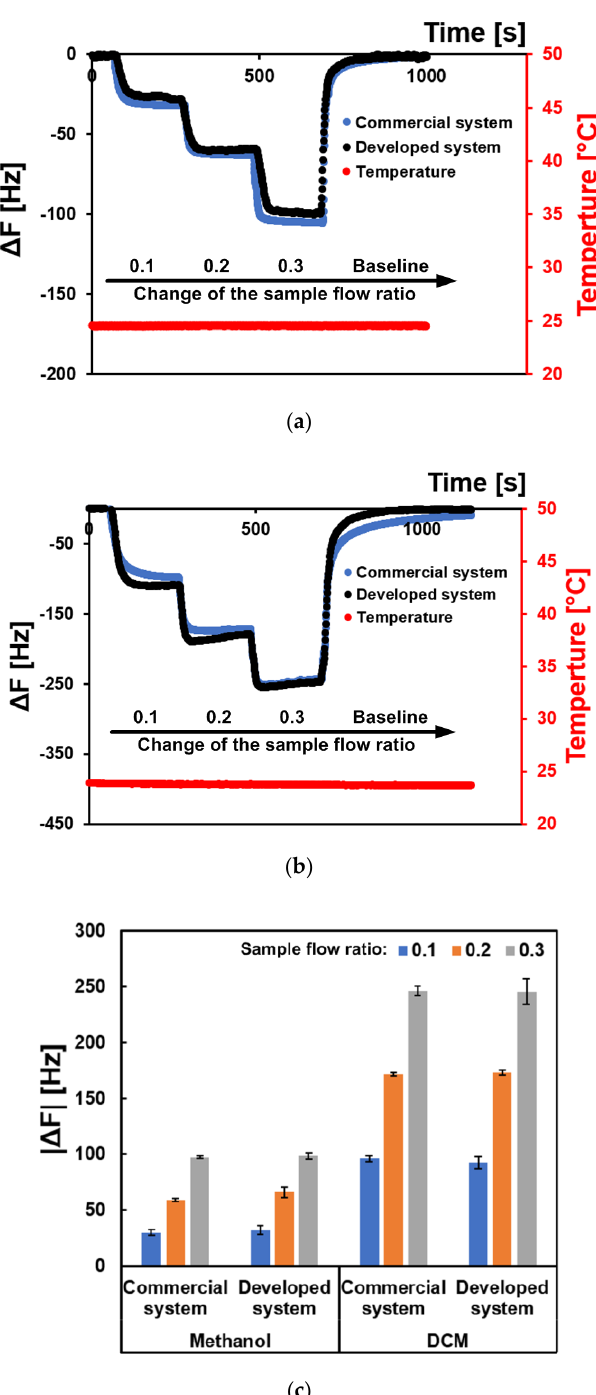
Figure 7. Direct comparison of the measurement results between the developed system and the commercial QCM system, Q-sense Analyzer (Biolin Scientific): frequency responses during the experimental time in the presence of ( a ) methanol and ( b ) DCM, and ( c ) comparison of average changes in frequency in presence of evaluated VOCs. Error bars indicate the standard deviation for three replicate measurements.